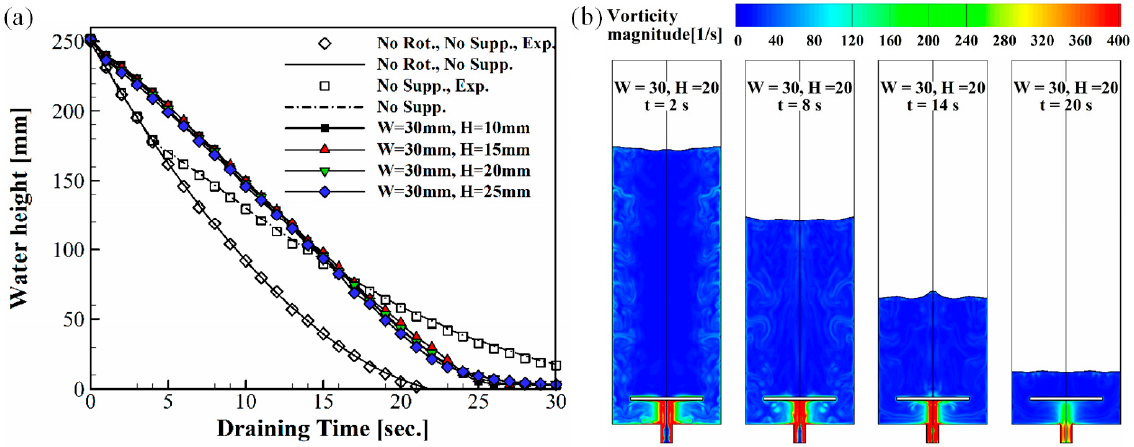
Figure 12. Comparison of the flow field with or without suppressor. ( a ) Variation of liquid height with different suppressor sizes. ( b ) Vorticity evolution with the suppressor. (Reprinted with permission from Ref. [68]. 2015, Springer Nature).